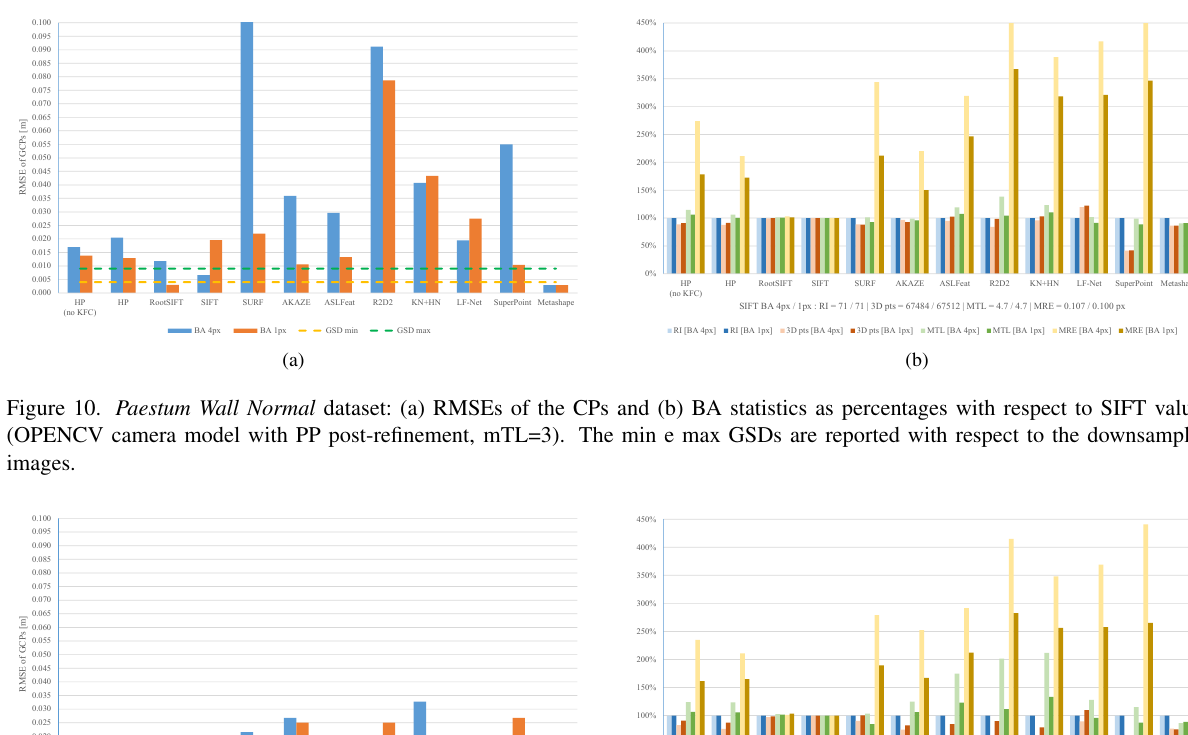
Figure 9. Ventimiglia Theatre Nadiral+Oblique dataset: matches comparison in a nadiral-oblique image pair with the largest overlap for (a) the proposed HP, (b) R2D2, (c) SuperPoint and (d) SIFT.